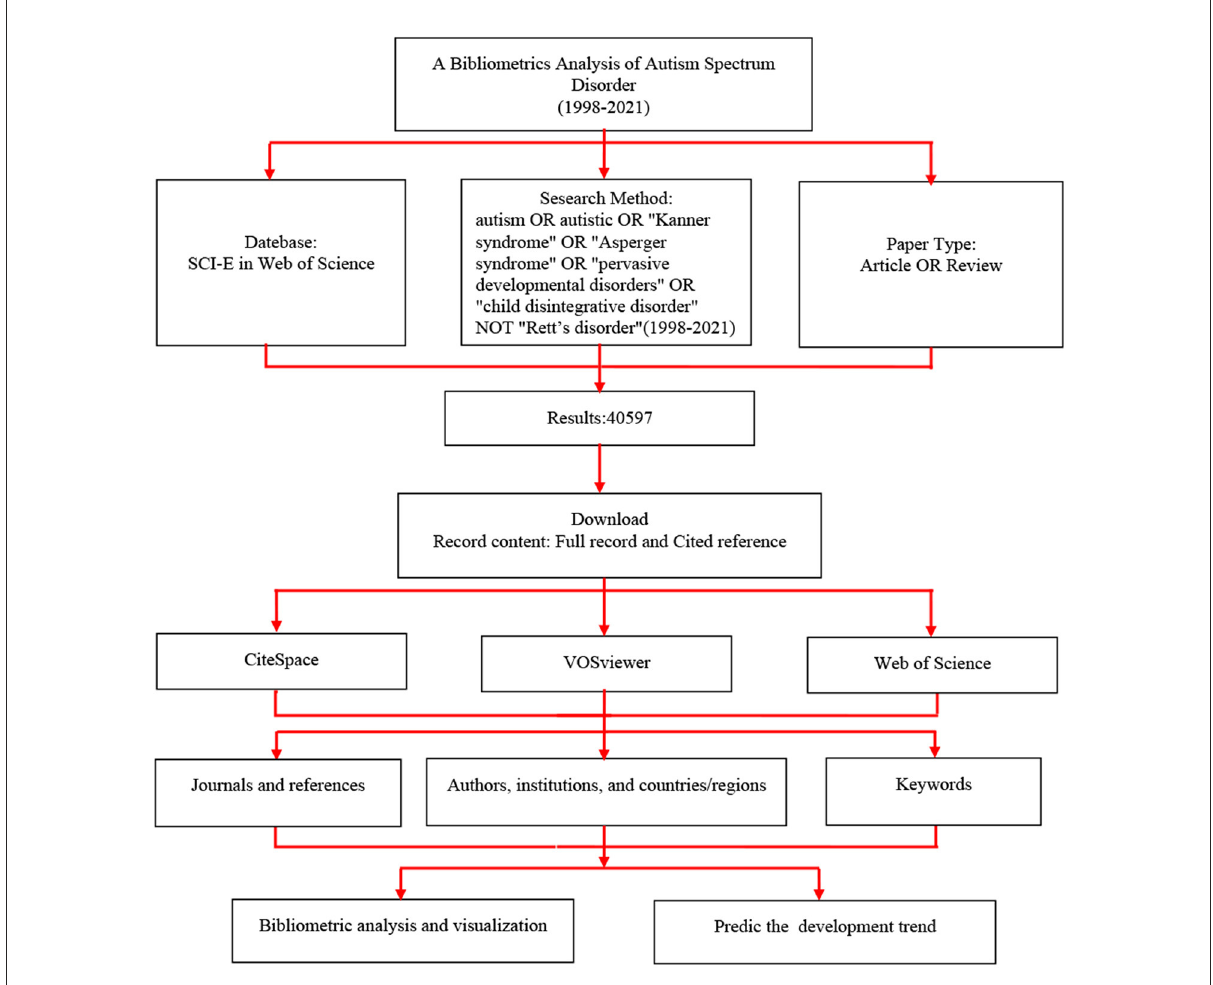
FIGURE1 Flow chart of bibliometrics analysis. SCI-E, Science citation index